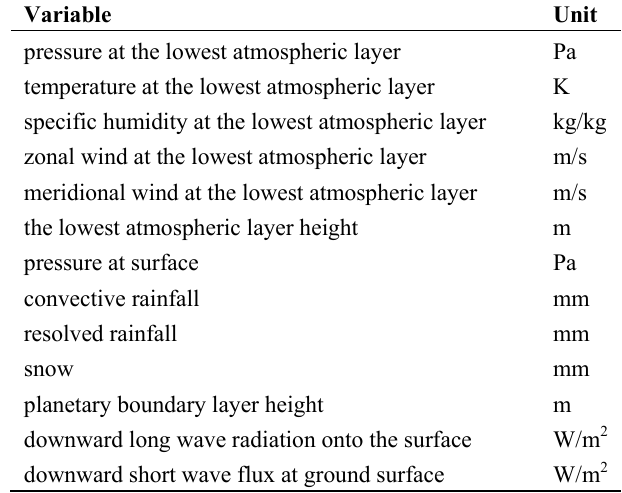
Table 1. Meteorological forcing data required to drive the CoLM in the offline